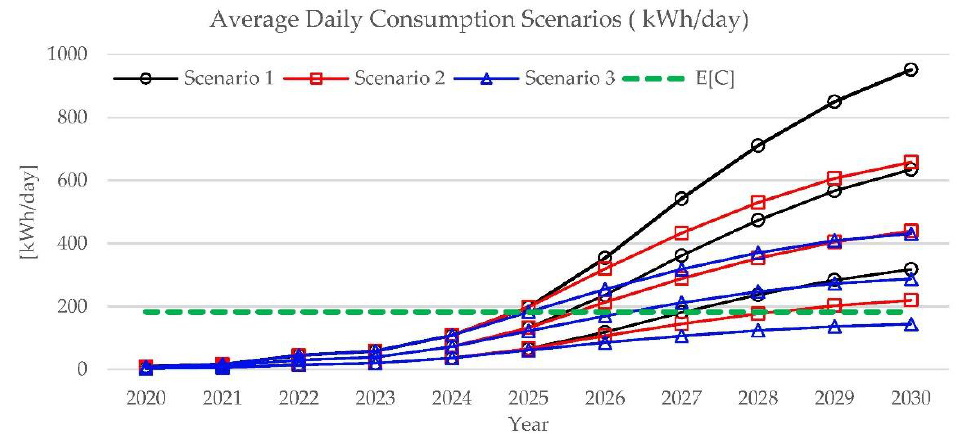
Figure 18. Energy Consumption Projection Scenarios. E(C) is the average value of energy consump- tion considering all years in all scenarios.